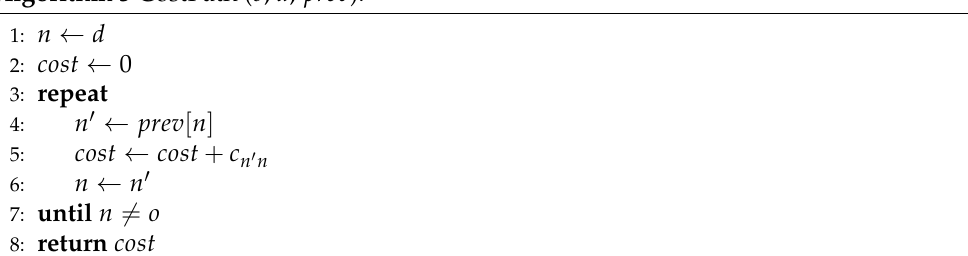
Algorithm 3 CostPath ( o , d , prev ).